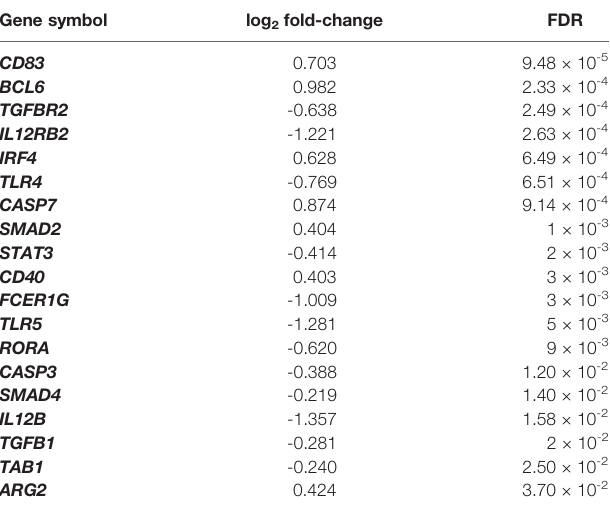
TABLE 1 | Selection of DEGs that are related to the immune response at the hepatic lymph node in chronic ovine infection with F. hepatica . Gene symbol log 2